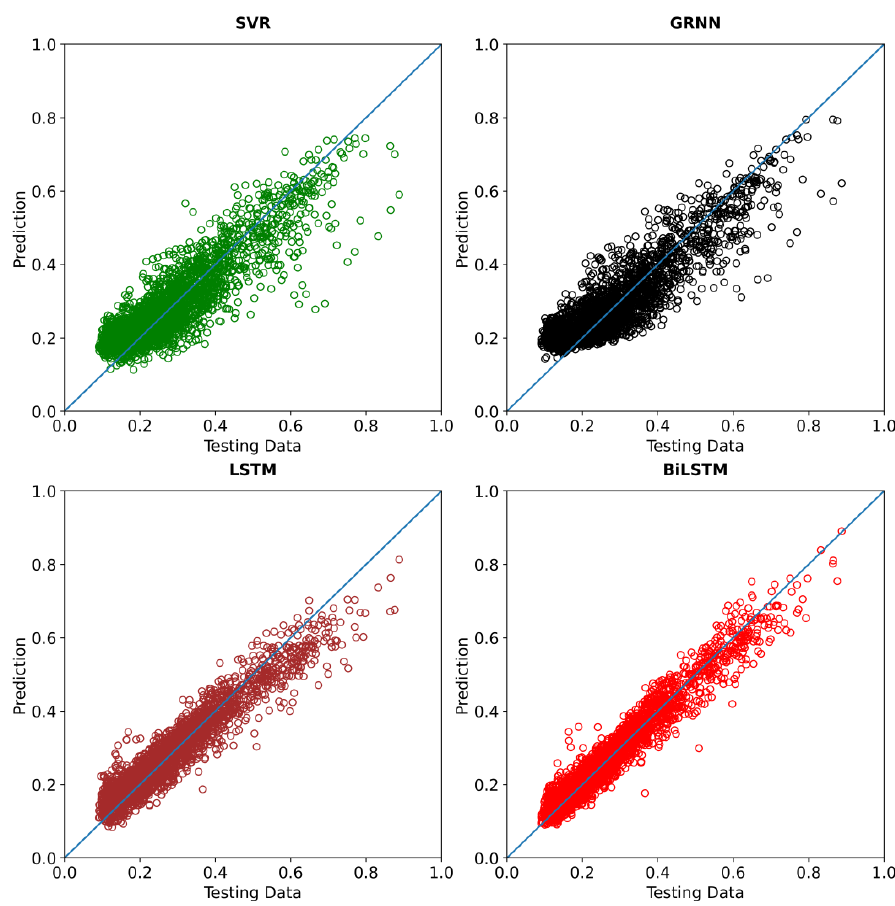
Figure 15. Scatter plot of the results of the significant wave height predictions with the SVR (upper left plot), GRNN (upper right plot), LSTM (lower left plot), and BiLSTM (lower right plot) methods with testing data at the observation location in Jakarta Bay, Java